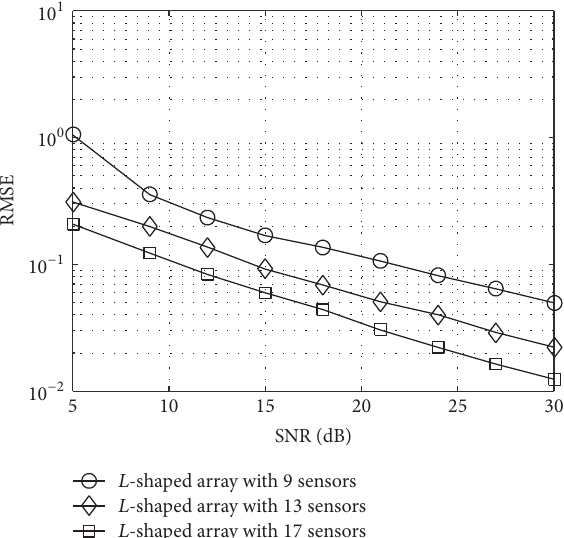
Figure 5: Total RMSE versus SNR for 𝑁 = 13 sensors, 𝐾 = 500 samples, and DoAs: {30 ∘ ,45 ∘ } and {50 ∘ , 55 ∘ } . Figure 6: Total RMSE versus SNR (performance of the ALS-Tucker algorithm for different number of sensors).